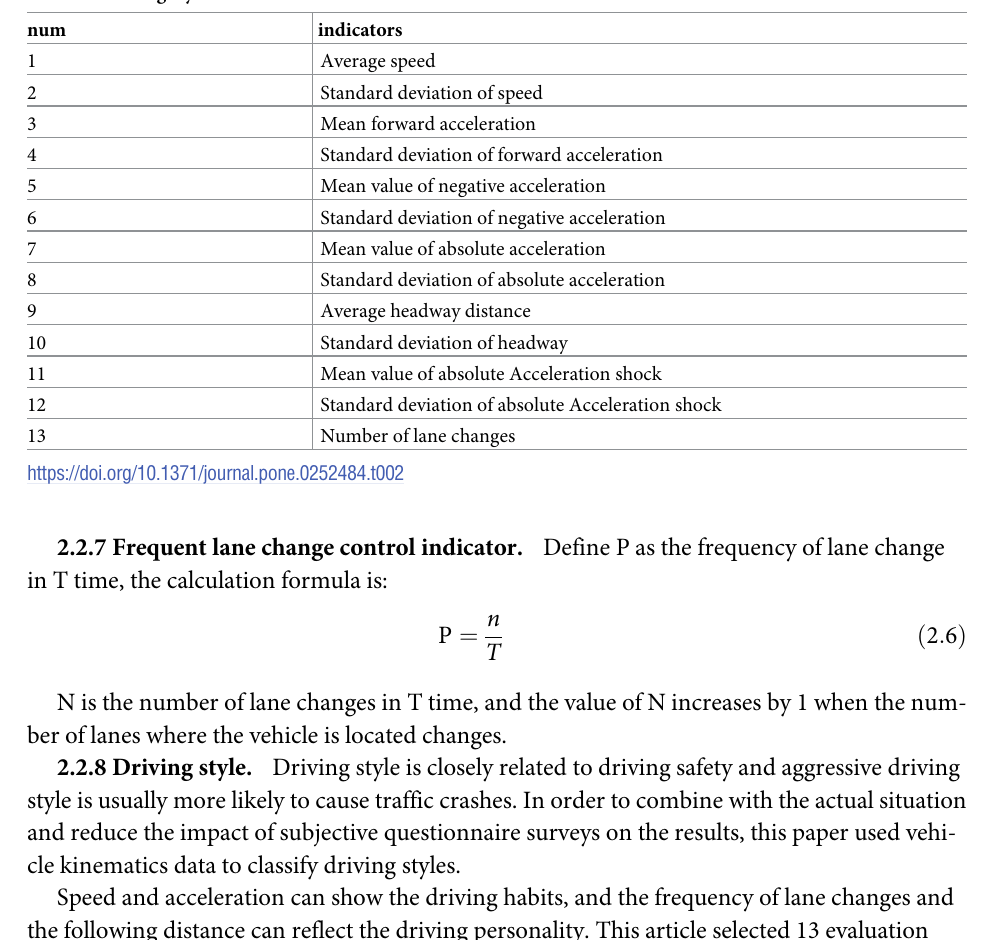
Table 2. Driving style evaluation